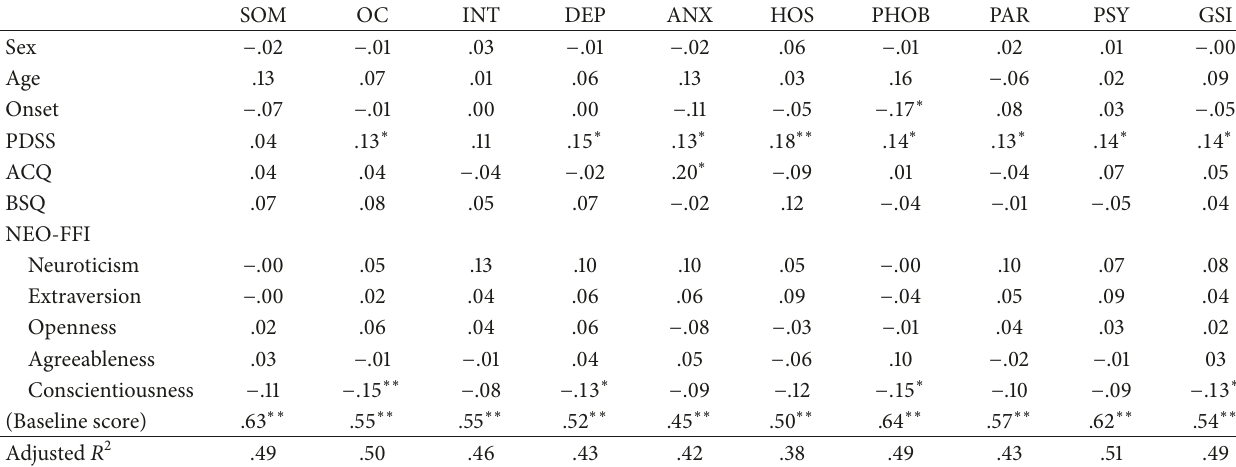
Table 3: Unique predictors of change in broad dimensions of psychopathology (𝑁 = 200)